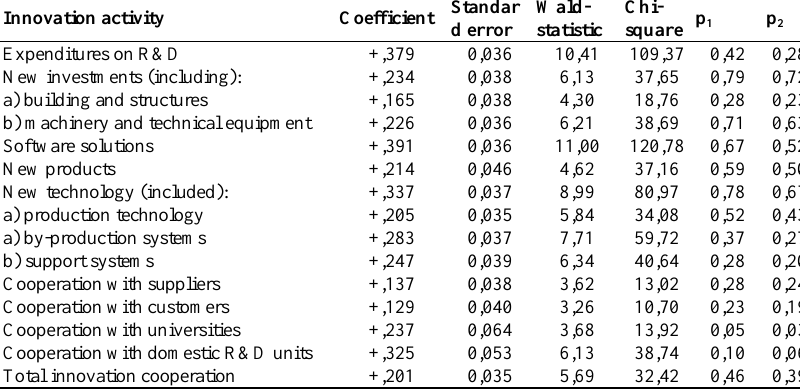
Table 3. Coefficient value by independent variable „domestic range”, in probit